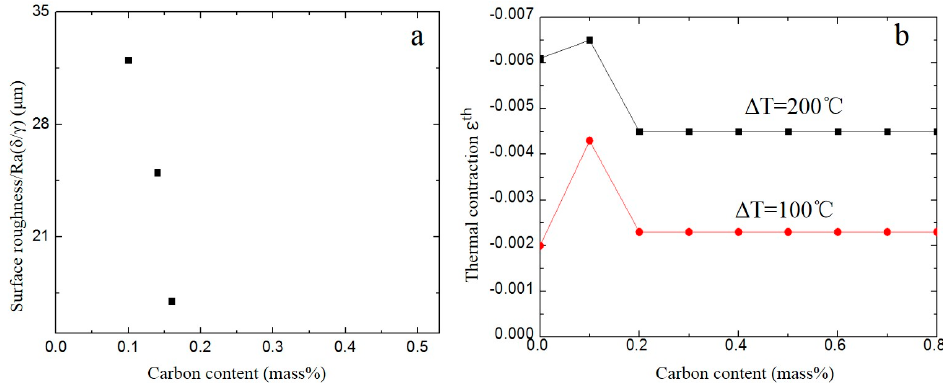
Figure 8. ( a ) relationship between the surface roughness and carbon content; ( b ) influence of carbon content on thermal contraction of iron-carbon alloys at different undercooling Δ T [11].